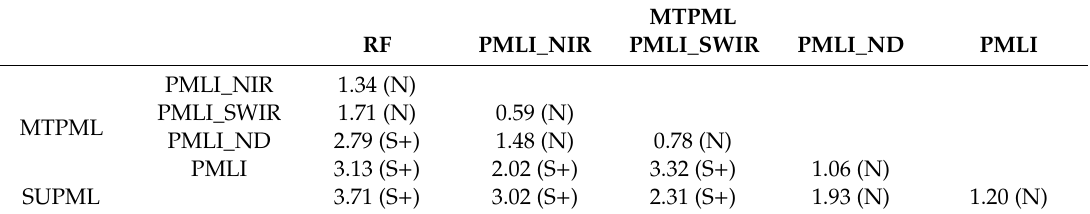
Figure 10. Visual comparison of PML mapping results in the second subset region of GY. ( a ) June 1–15 2018 composited Sentinel-2 image. ( b ) PML mapping results of PMLI using the MTPML workflow. (b) PML mapping results of PMLI_NIR using the MTPML workflow. ( d ) PML mapping results of PMLI_SWIR using the MTPML workflow. ( e ) PML mapping results of PMLI_ND using the MTPML workflow. ( f ) PML mapping results of RF using the MTPML workflow. Table 4. McNemar’s test result in HS.